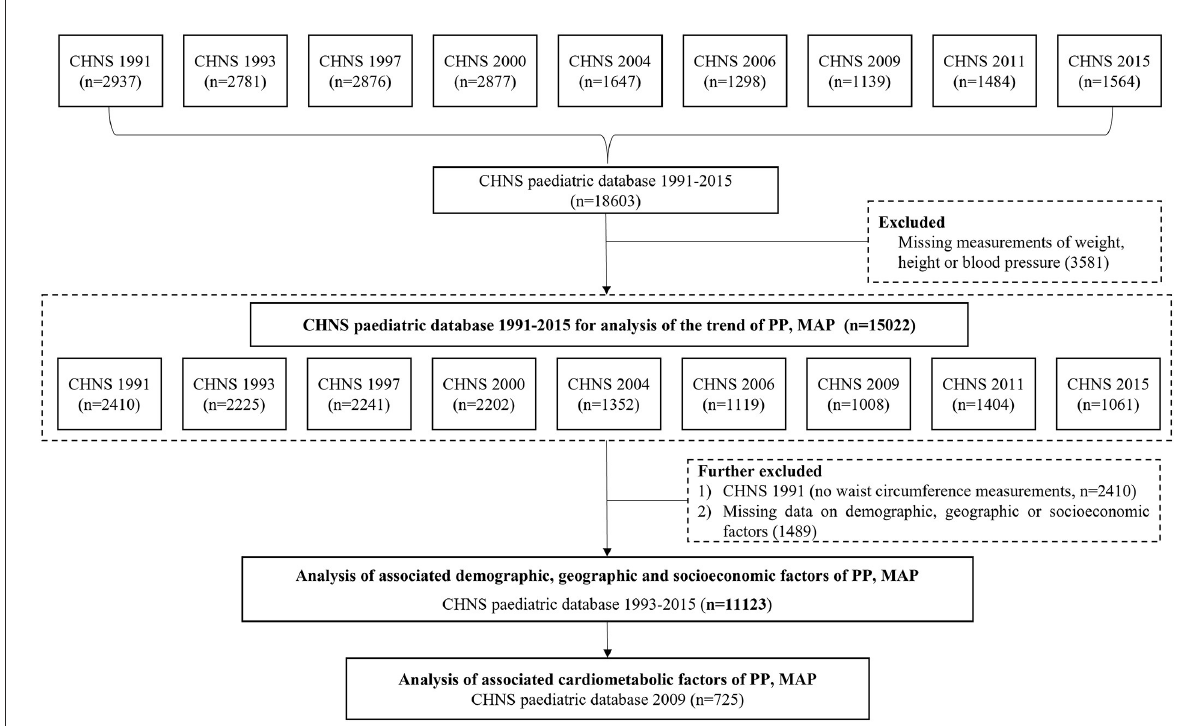
FIGURE1 The flowchart for selecting subjects in CHNS 1991-2015 for the analysis of PP and MAP. Note: CHNS, the China Health and Nutrition Survey; PP, pulse pressure; MAP, mean arterial